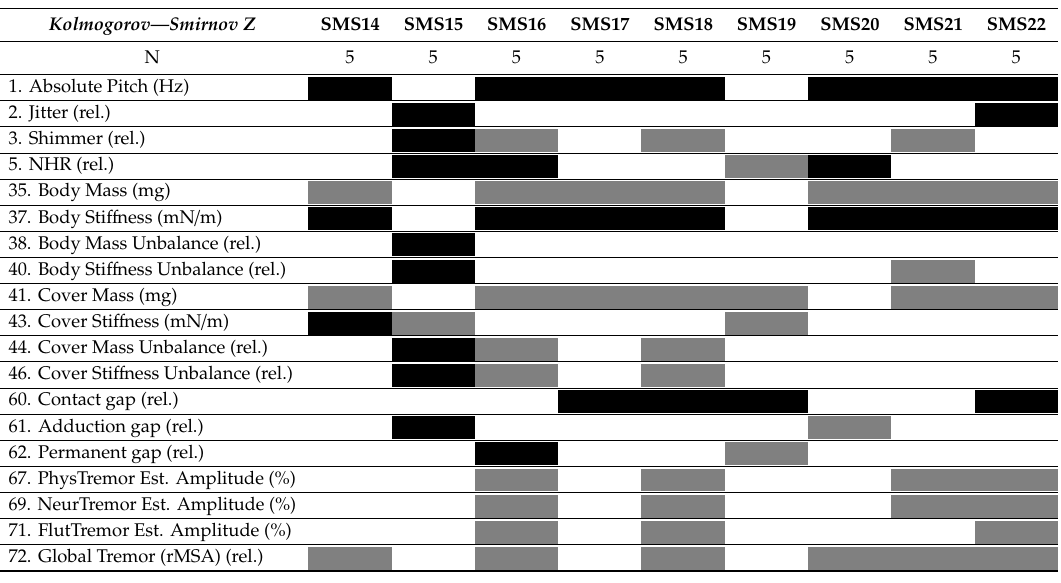
Table 5. Greyscale for above or below normality